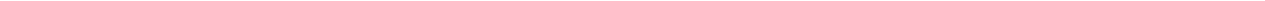
Figure 7 | The ACF1–SNF2H chromatin remodeller interacts with HBO1 and accumulates at ultraviolet-damaged DNA. ( a ) ShCtl, shHBO1 and shDDB2 cells were irradiated with 50Jm (cid:2) 2 ultraviolet and cultured for 30min. Cells were co-immunostained with indicated antibodies. Scale bars, 5 m m. ( b ) Depletion of HBO1-suppressed ACF1 accumulation at damage sites. ShCtl and shHBO1 cells were irradiated with 50Jm (cid:2) 2 ultraviolet and cultured